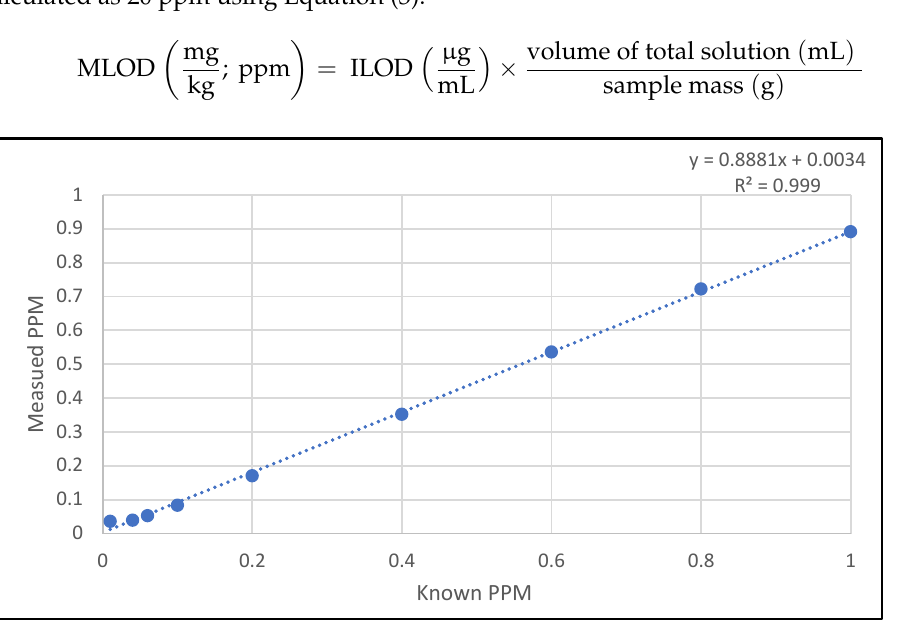
Figure 9. Plotting known total fluorine concentration against measured values.